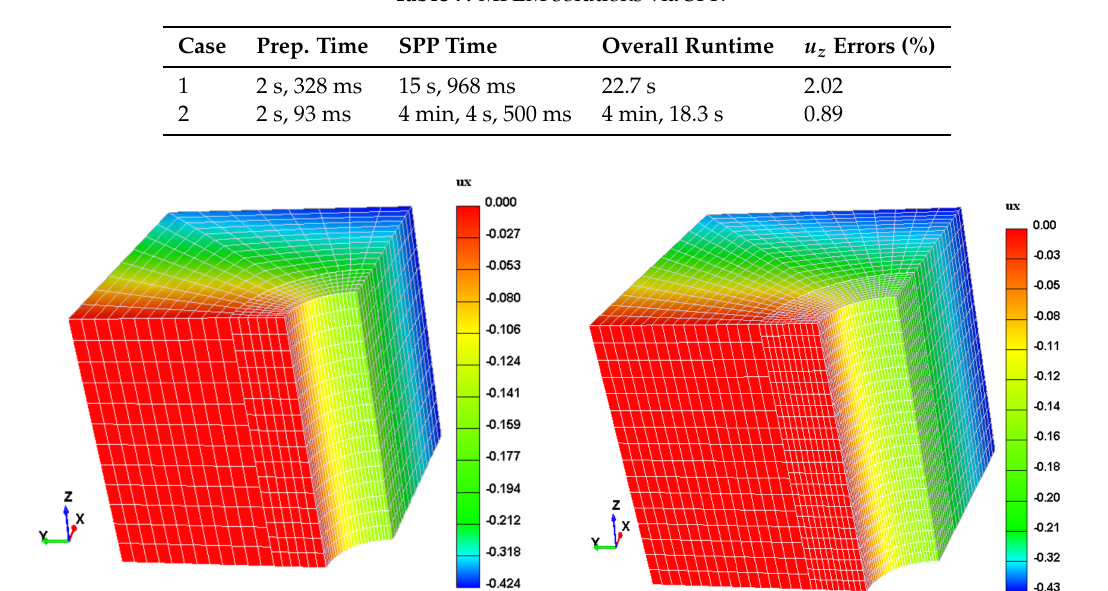
Table 7. MFEM solutions via SPP.